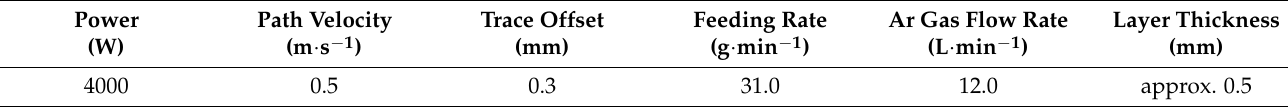
Table 1. Laser metal deposition process parameters for Al 0.3 CoCrFeNiNb 0.5 . Power Path